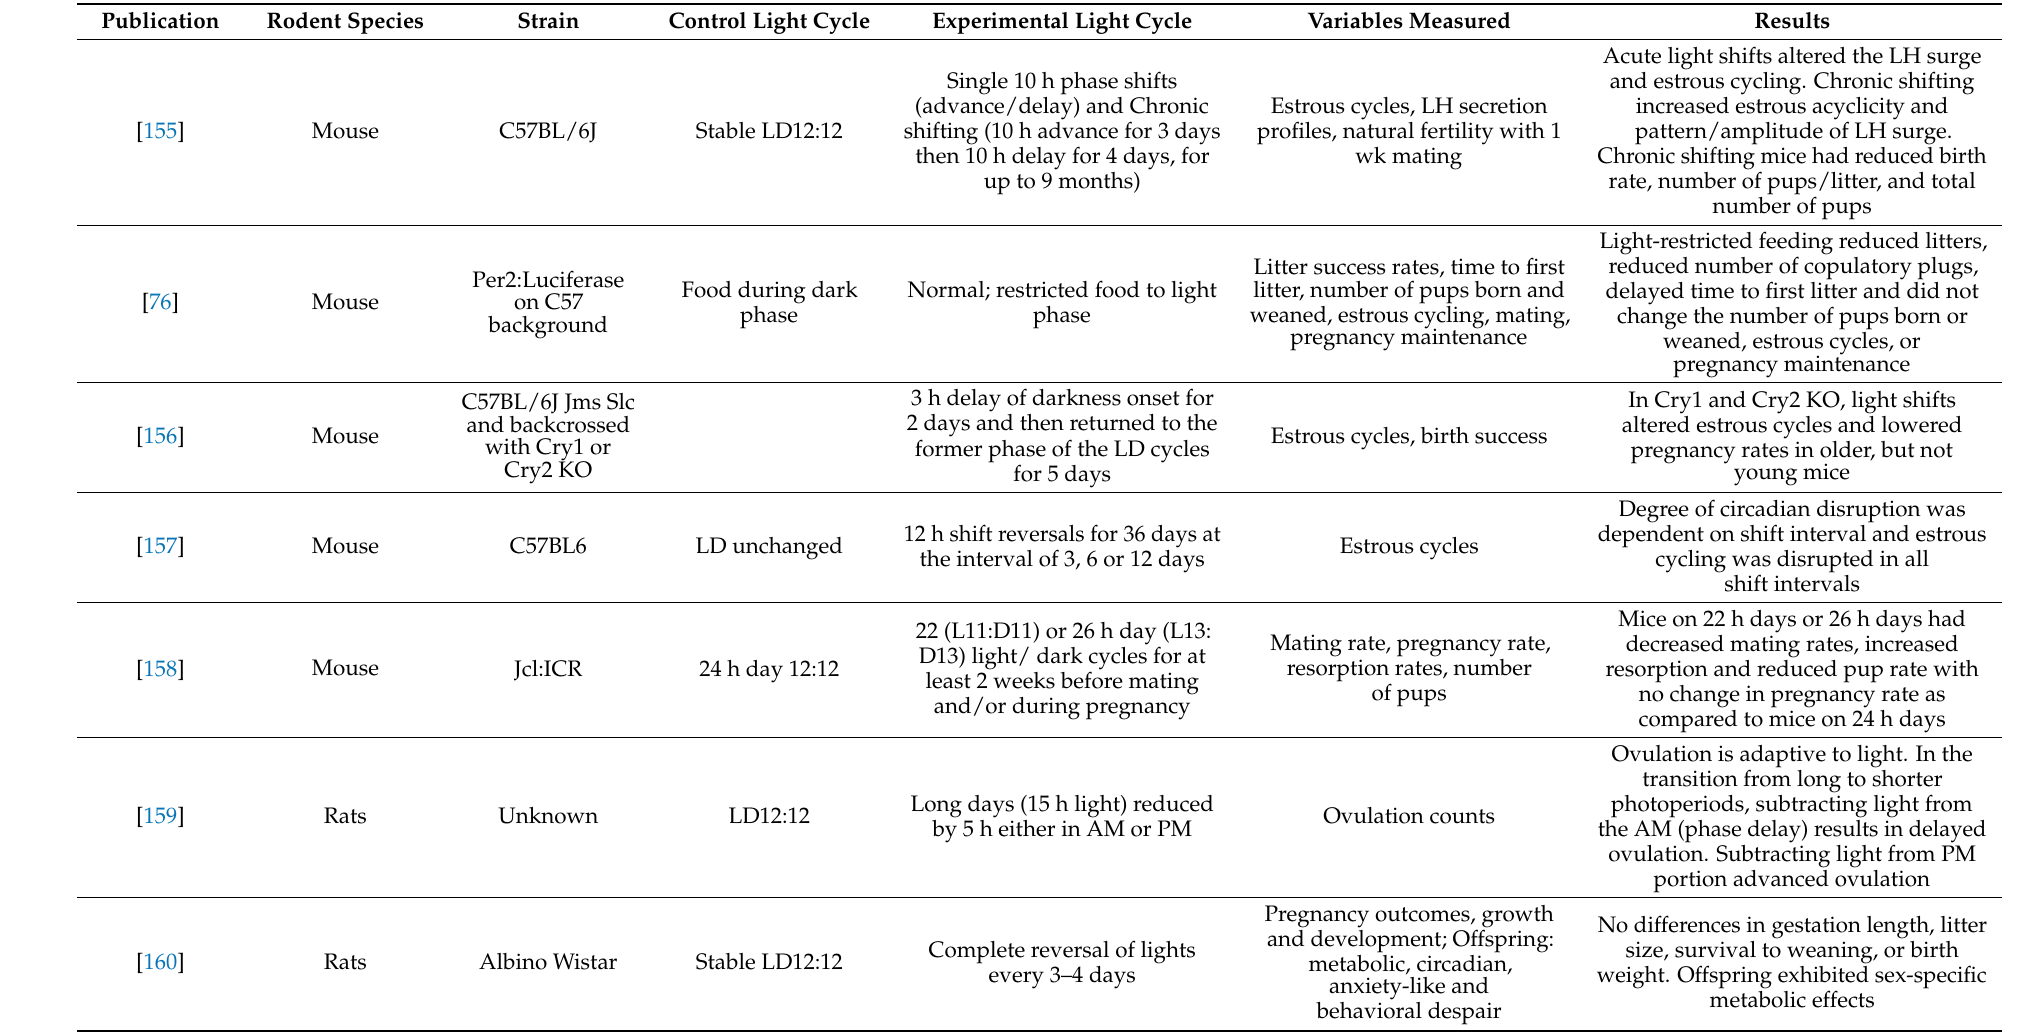
Table 2. Summary of outcomes in rodent light-shift models included in this